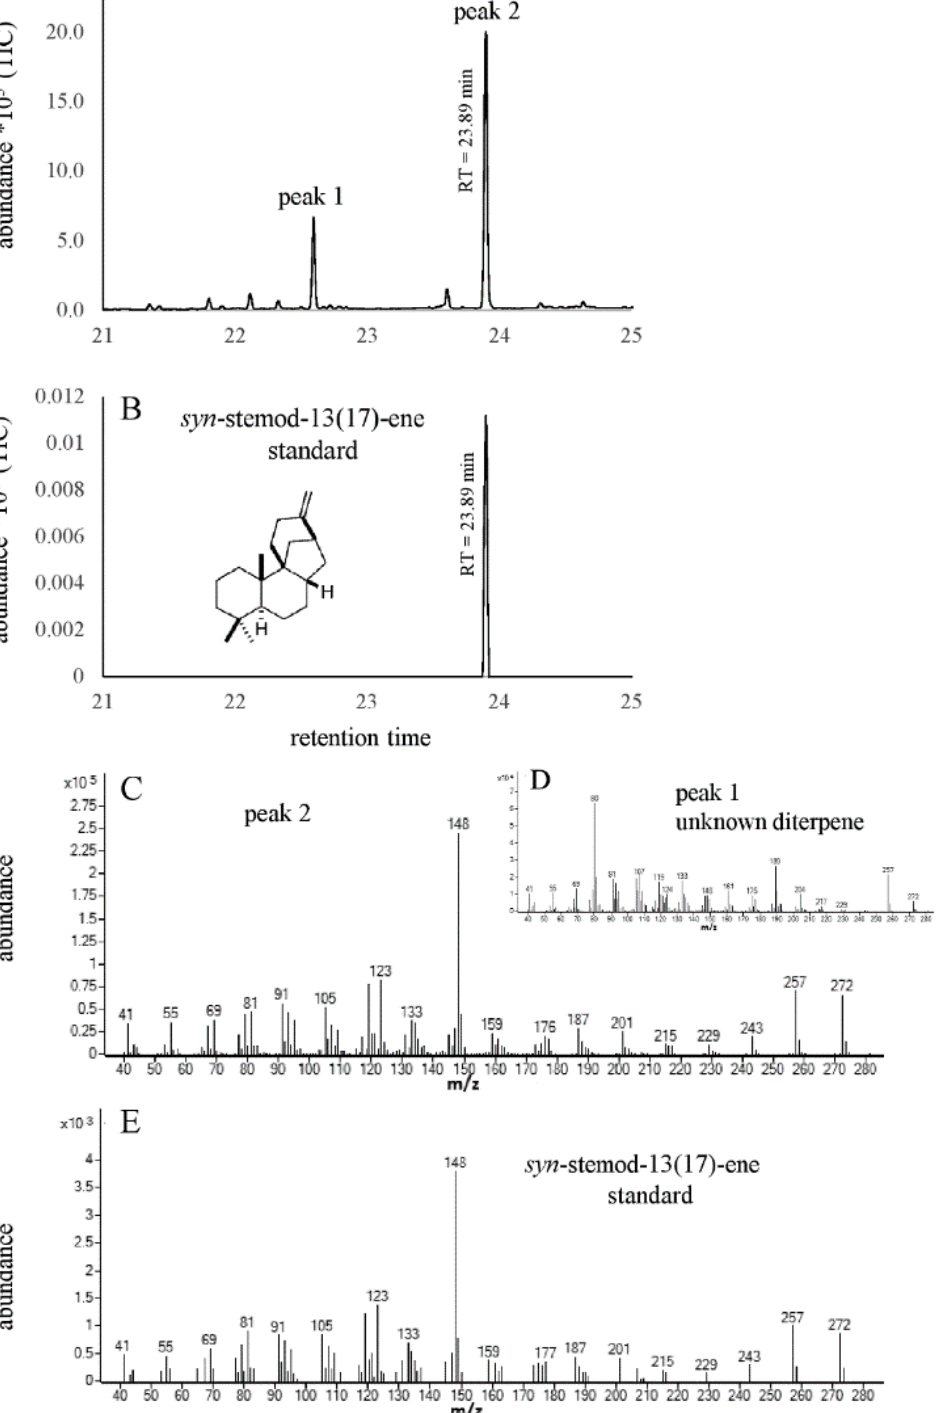
Figure 5. ( A ) = GC-MS total ion chromatogram (TIC) showing unknown diterpene (peak 1) and syn - stemod-13(17)-ene (peak 2) produced by TpdiTPS1 from syn -CDP. ( B ) = TIC of syn -stemod-13(17)-ene standard produced by Oryza sativa syn -stemod-13(17)-ene synthase (OsKSL11) [60]. ( C – E ) = mass spectra of peak 2, peak 1, and an authentic syn - stemod-13(17)-ene standard produced by OsKSL11 [60], respectively.